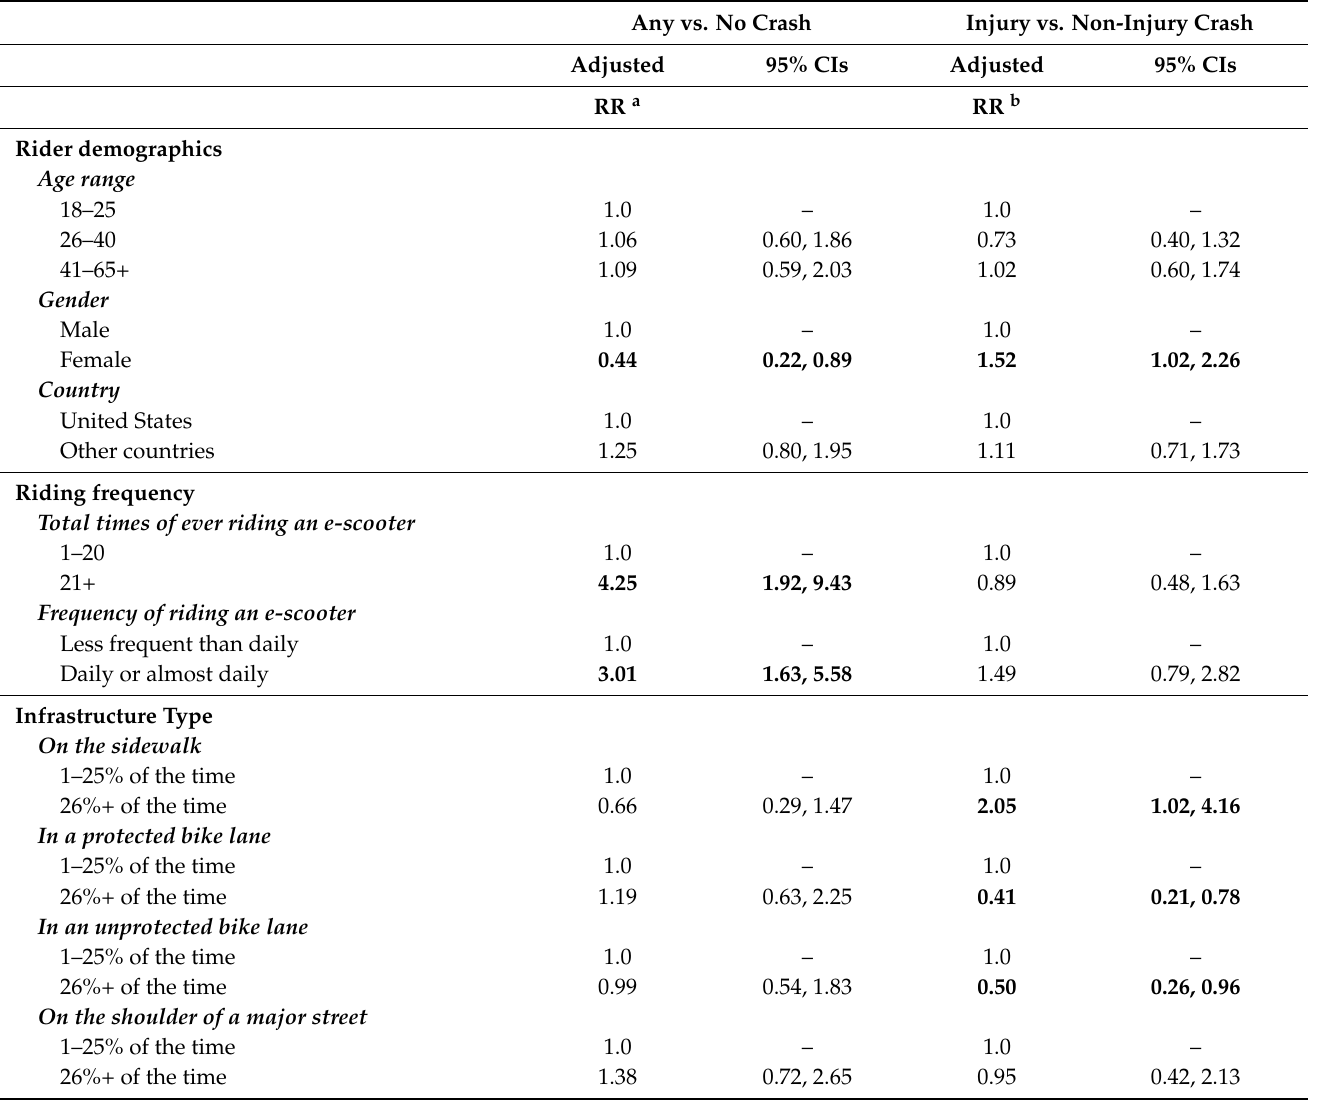
Table 2. Associations between scooter rider demographics, riding frequency and locations, and helmet use and the riders’ self-reported involvement in an e-scooter related crash. Any vs. No Crash Injury vs. Non-Injury Crash Adjusted 95%